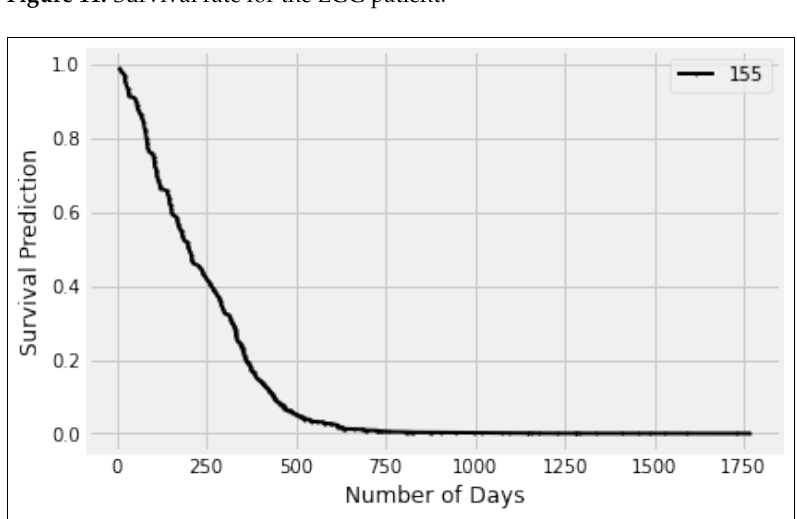
Figure 11. Survival rate for the LGG patient.